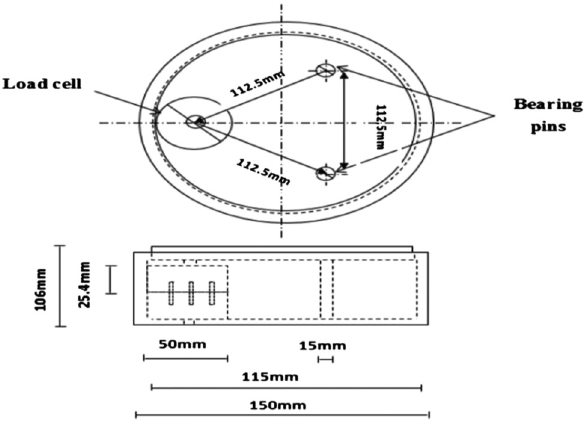
Figure 2: Designation of the load cell mold [ 15 ] .